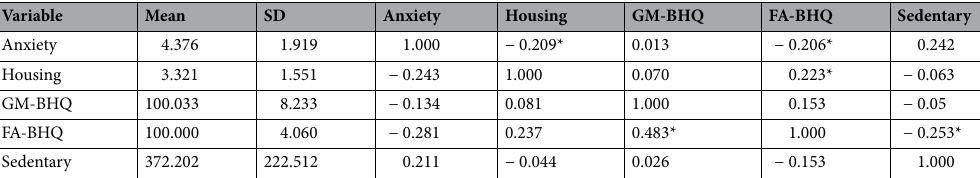
Table 3. Descriptive statistics and correlations. n = 109. Correlations appear below the diagonal and partial correlations (controlled for age and sex, and experiment location) above diagonal. R values with an asterisk (*) denote significance after FDR correction.